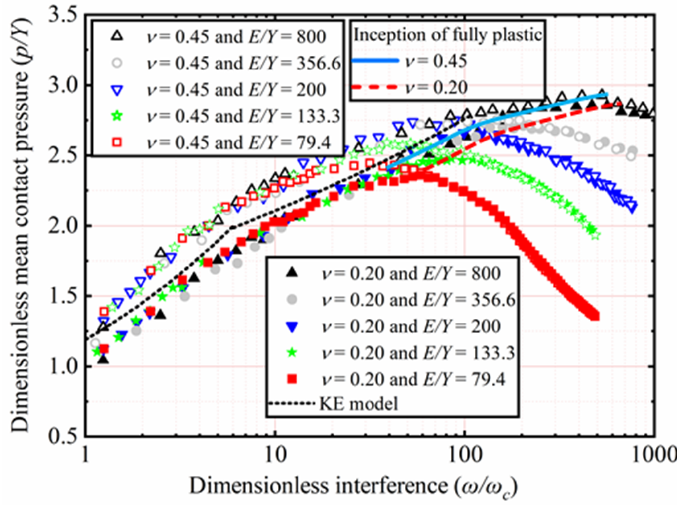
Figure 11. p/Y as a function of ω/ω c for different Y and ν .